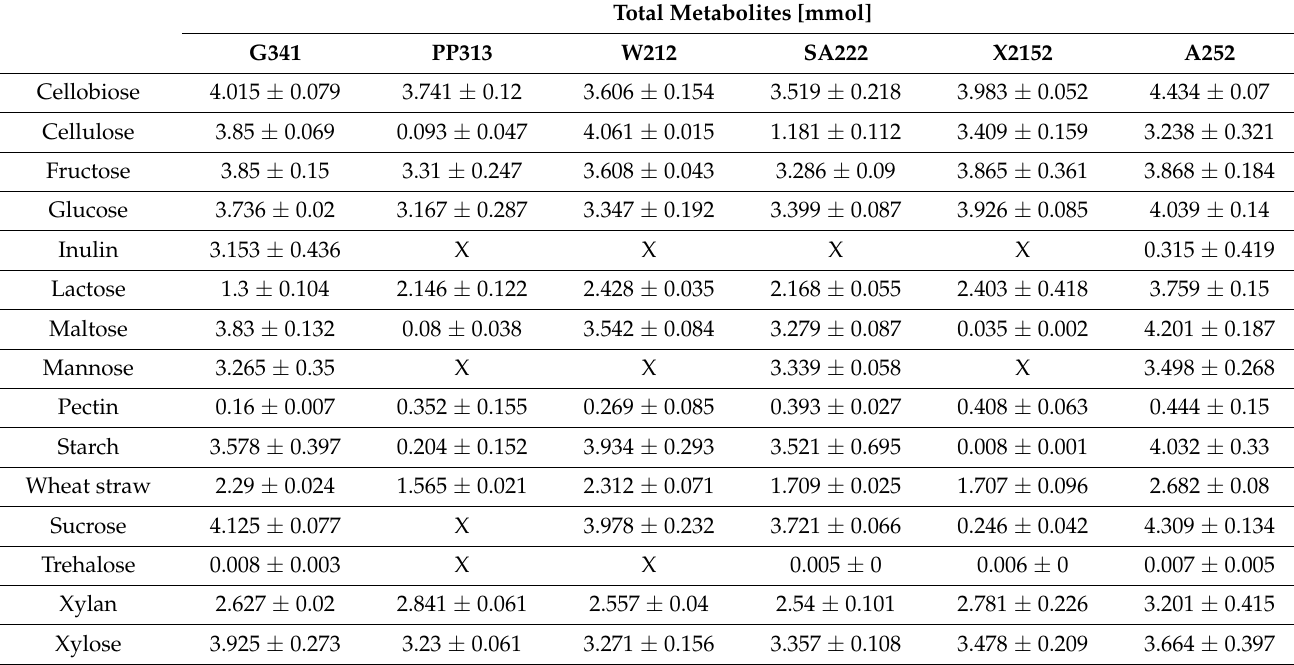
Table 1. Total metabolites (mmol) without ethanol produced by the isolates during growth on different